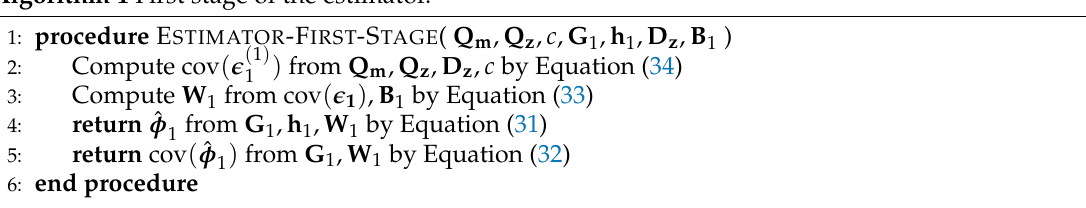
Algorithm 1 First stage of the